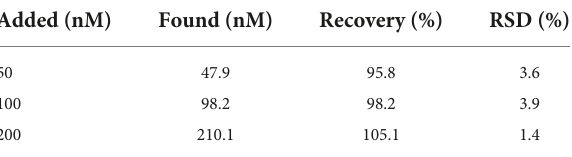
TABLE 1 Recovery assay in milk powder using PG-based aptasensor ( n = 3).